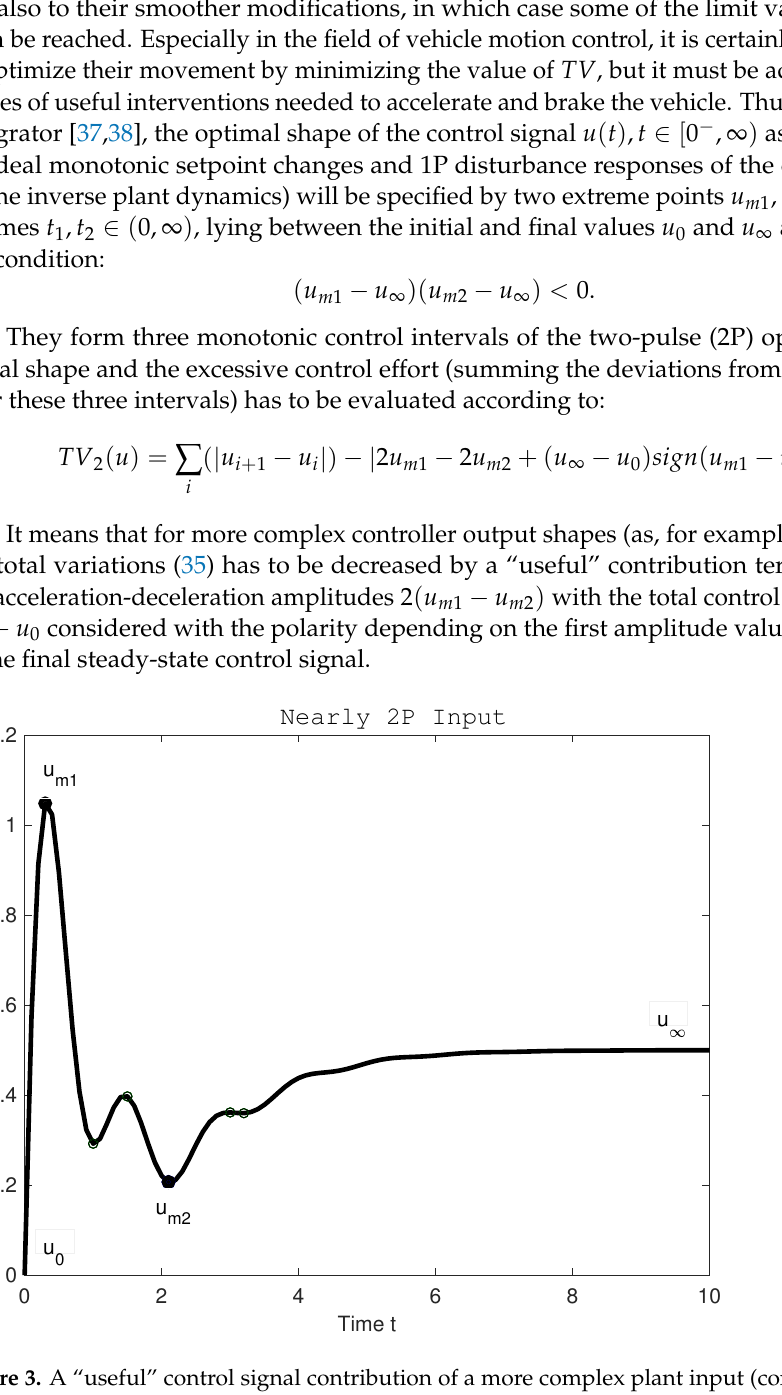
Figure 3. A “useful” control signal contribution of a more complex plant input (controller output) calculated as: TV 2 ( u ) = u m 1 − u 0 + u m 1 − u m 2 + u ∞ − u m 2 = 2 u m 1 − 2 u m 2 + u ∞ − u 0